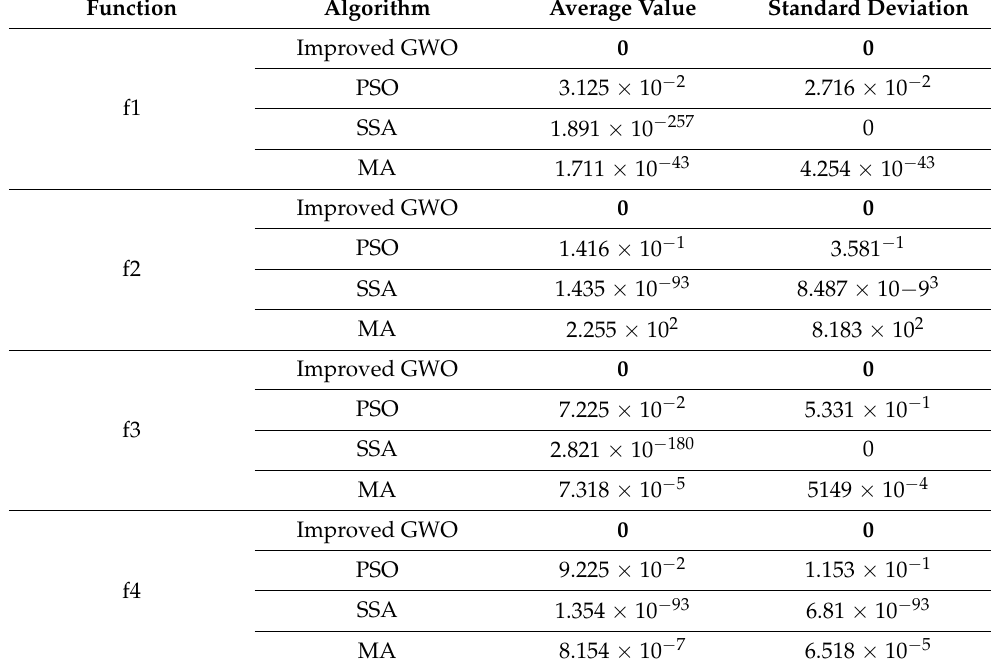
Table 4. Test functions